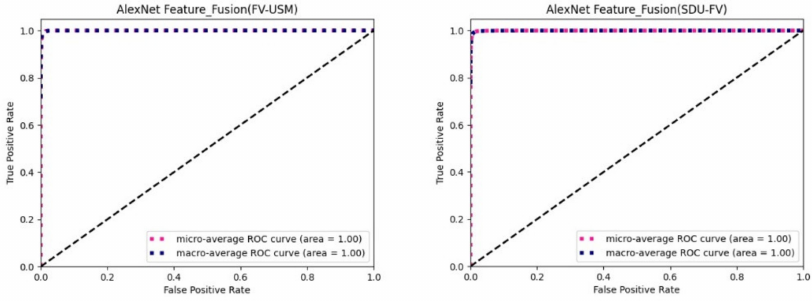
Figure 7. Fusion of identified ROC curves on AlexNet feature extraction